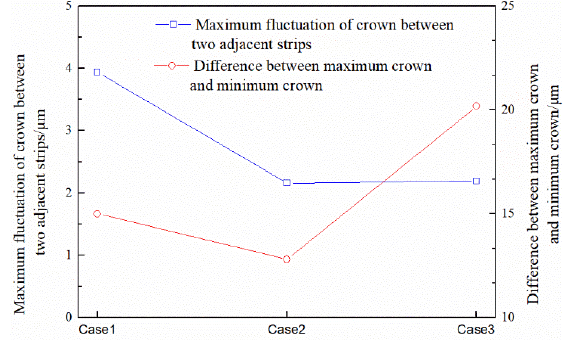
Figure 11. Strip crown fluctuation index in the middle and later stage of rolling unit.